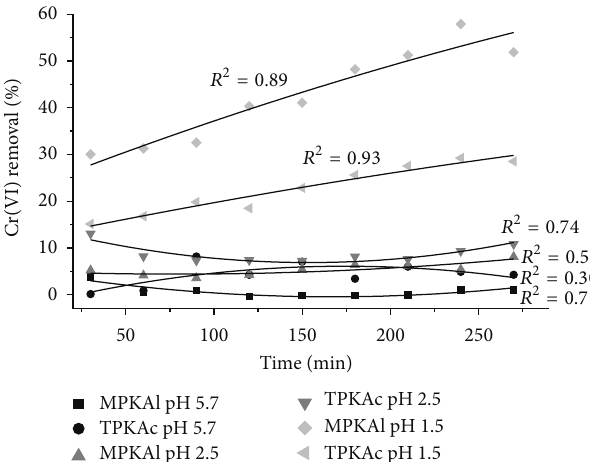
Figure 9: Cr(VI) removal percentages of MPKAl and TPKAc membranes as function of pH and time in the filtration system by continuous